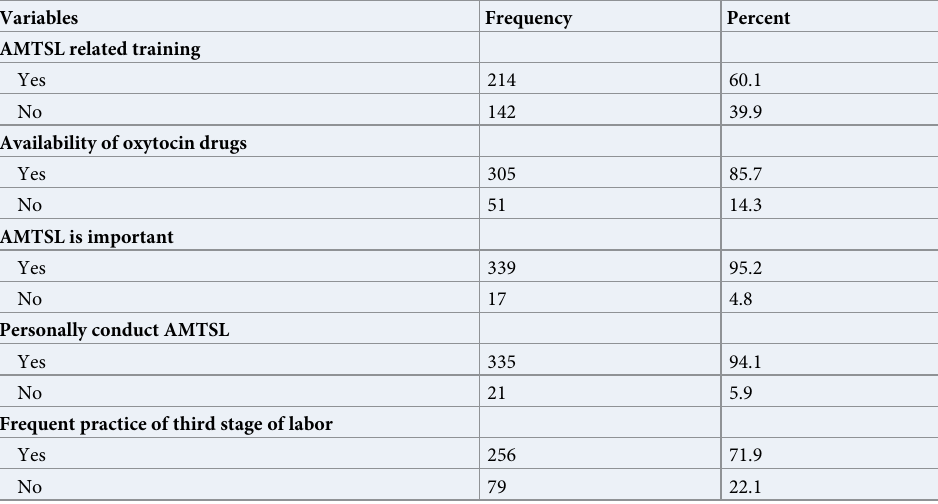
Table 2. Provider, institutional and supplies related characteristic of respondents.